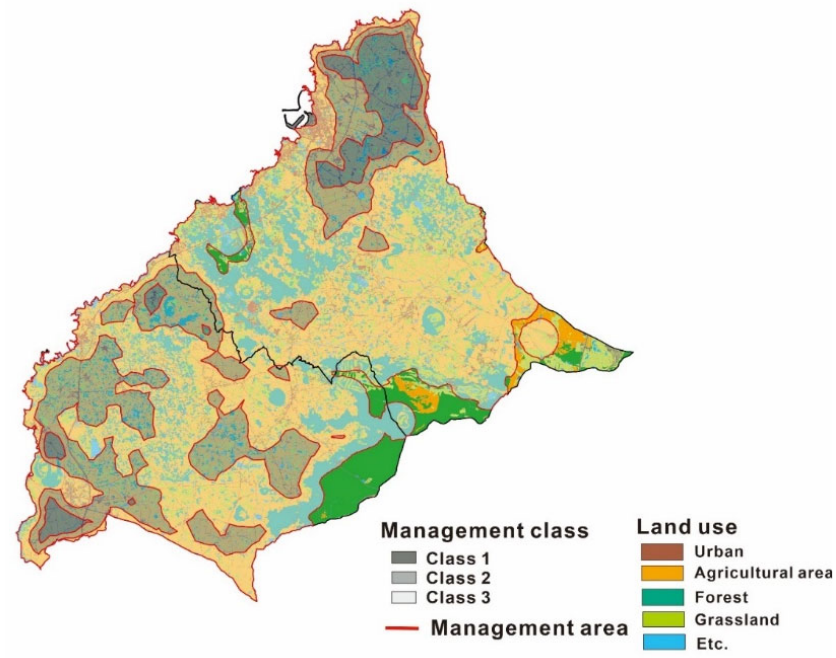
Figure 7. Suggested management zones for controlling N fertilizer use.